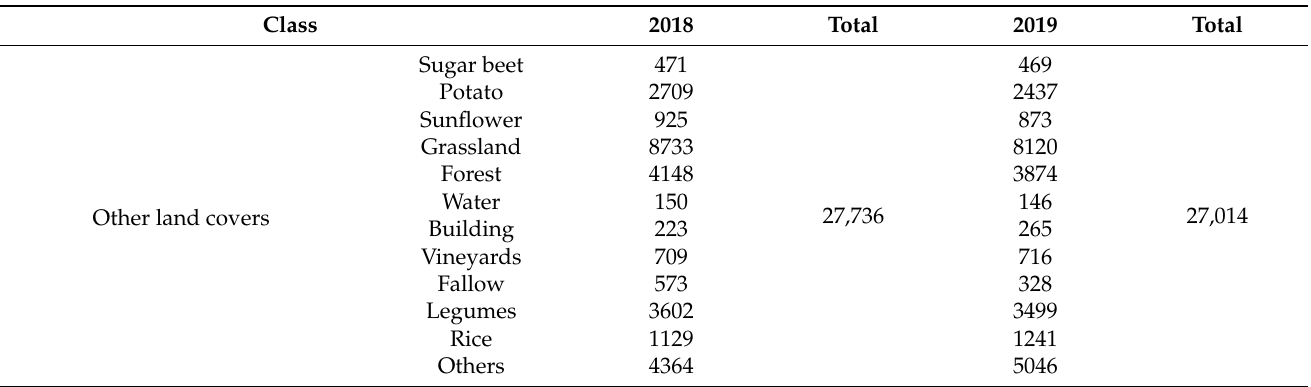
Table 1. The number of training samples in 2018 and